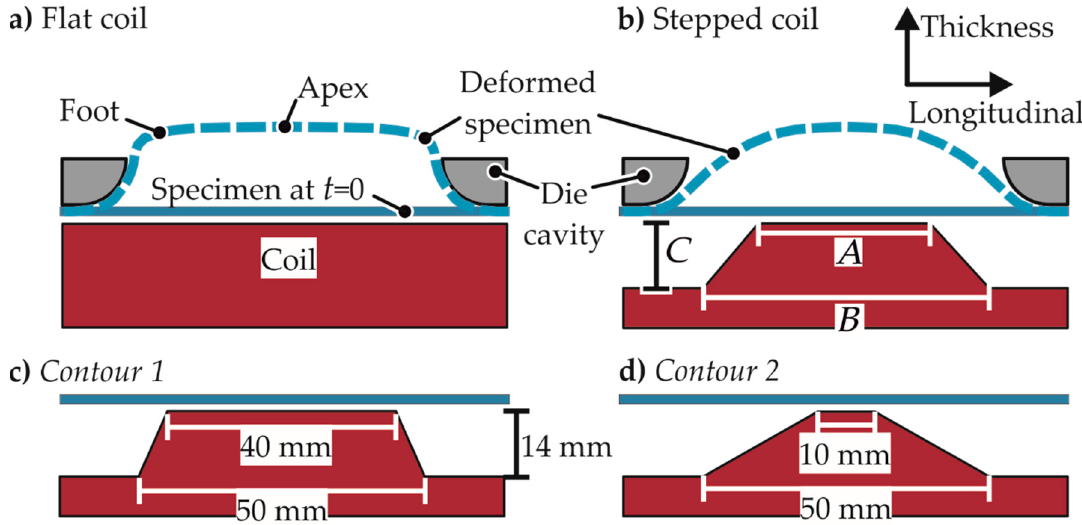
Figure 7. A coil that is flat in the longitudinal direction. ( a ) Typically used flat coil with bending at the foot; ( b ) A stepped coil; ( c , d ) two of the stepped contours used in the simulations.